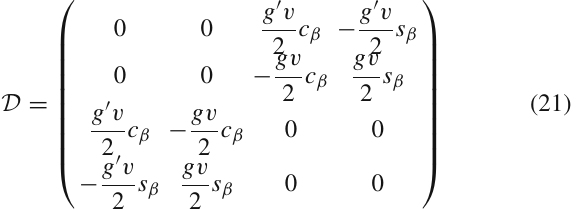
Fig. 2 Two-loop diagram of sbottom-self-energy insertions contribut- ingtotheSUSY–QCDcorrectionstothebottom-quarkself-energy.This involves bottom quarks b , bottom squarks ˜ b and gluinos ˜